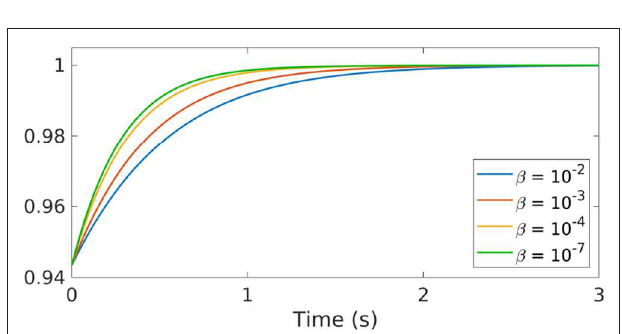
FIGURE 4 | Control function applied to the Kuramoto model [Equation (5)] with N different values of β .